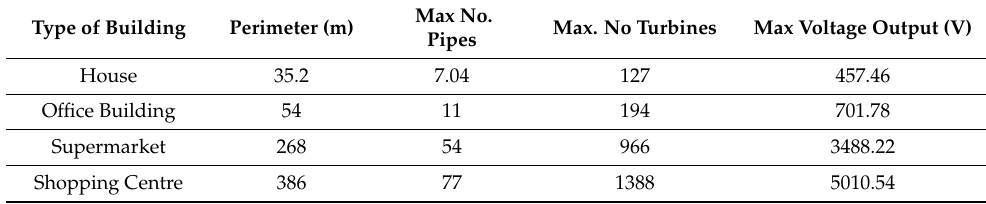
Table 6. Power generation of multiple